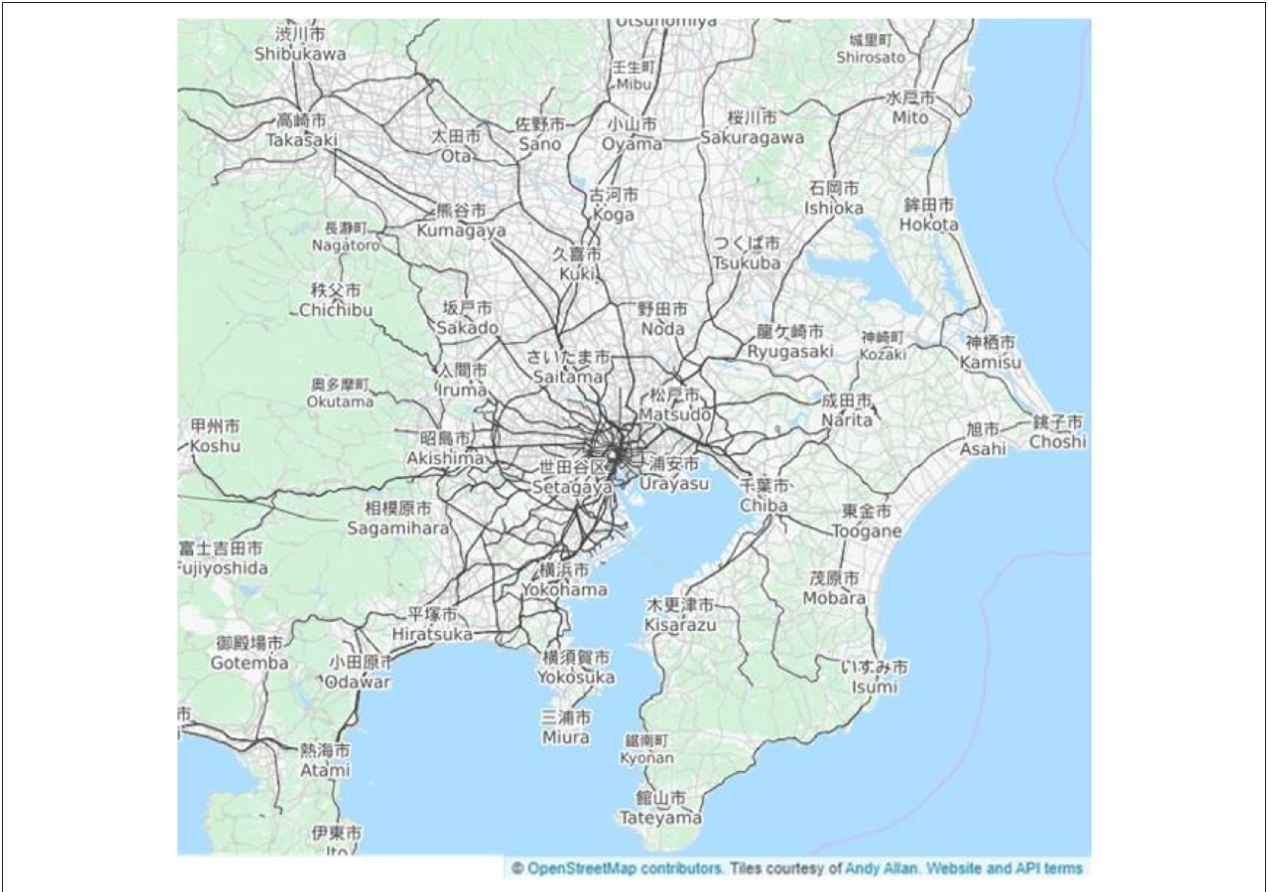
FIGURE 2 | The multimodal transport network of megacity